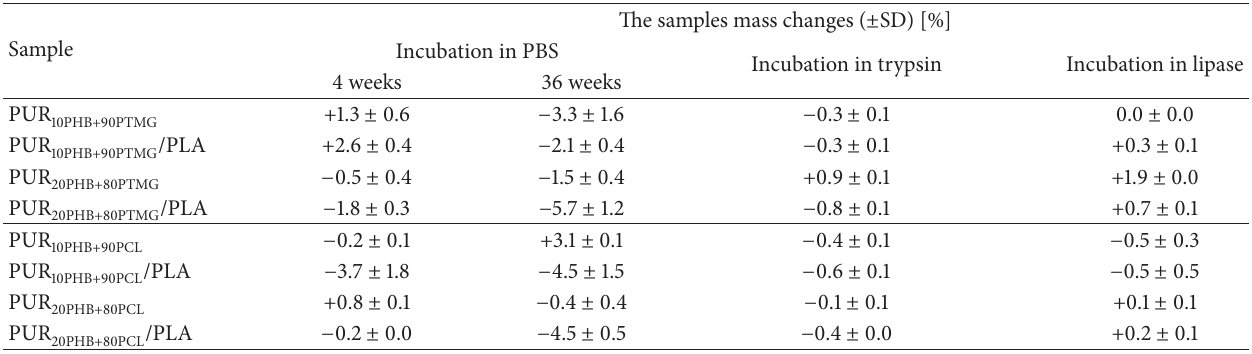
) and its blend (PUR /PLA) before and after incubation in PBS (4 10PHB+90PTMG 10PHB+90PTMG